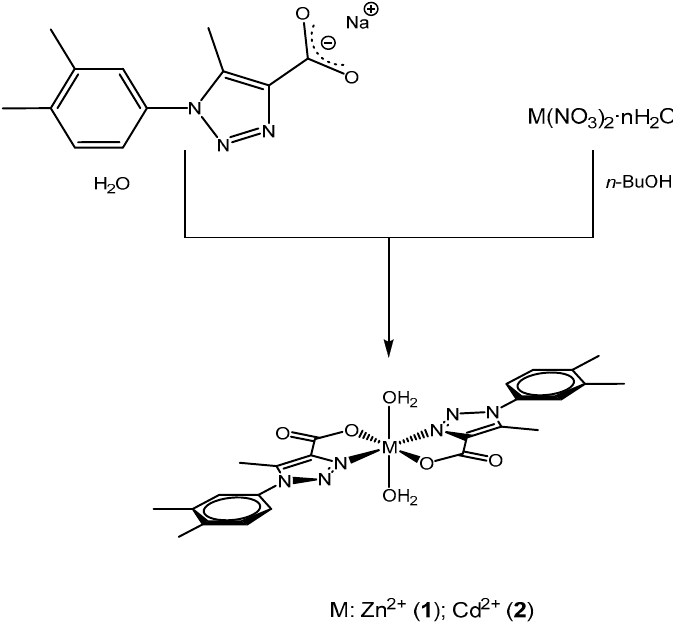
Figure 1. Scheme of the reaction to obtain complexes ( 1 ) and ( 2 ).